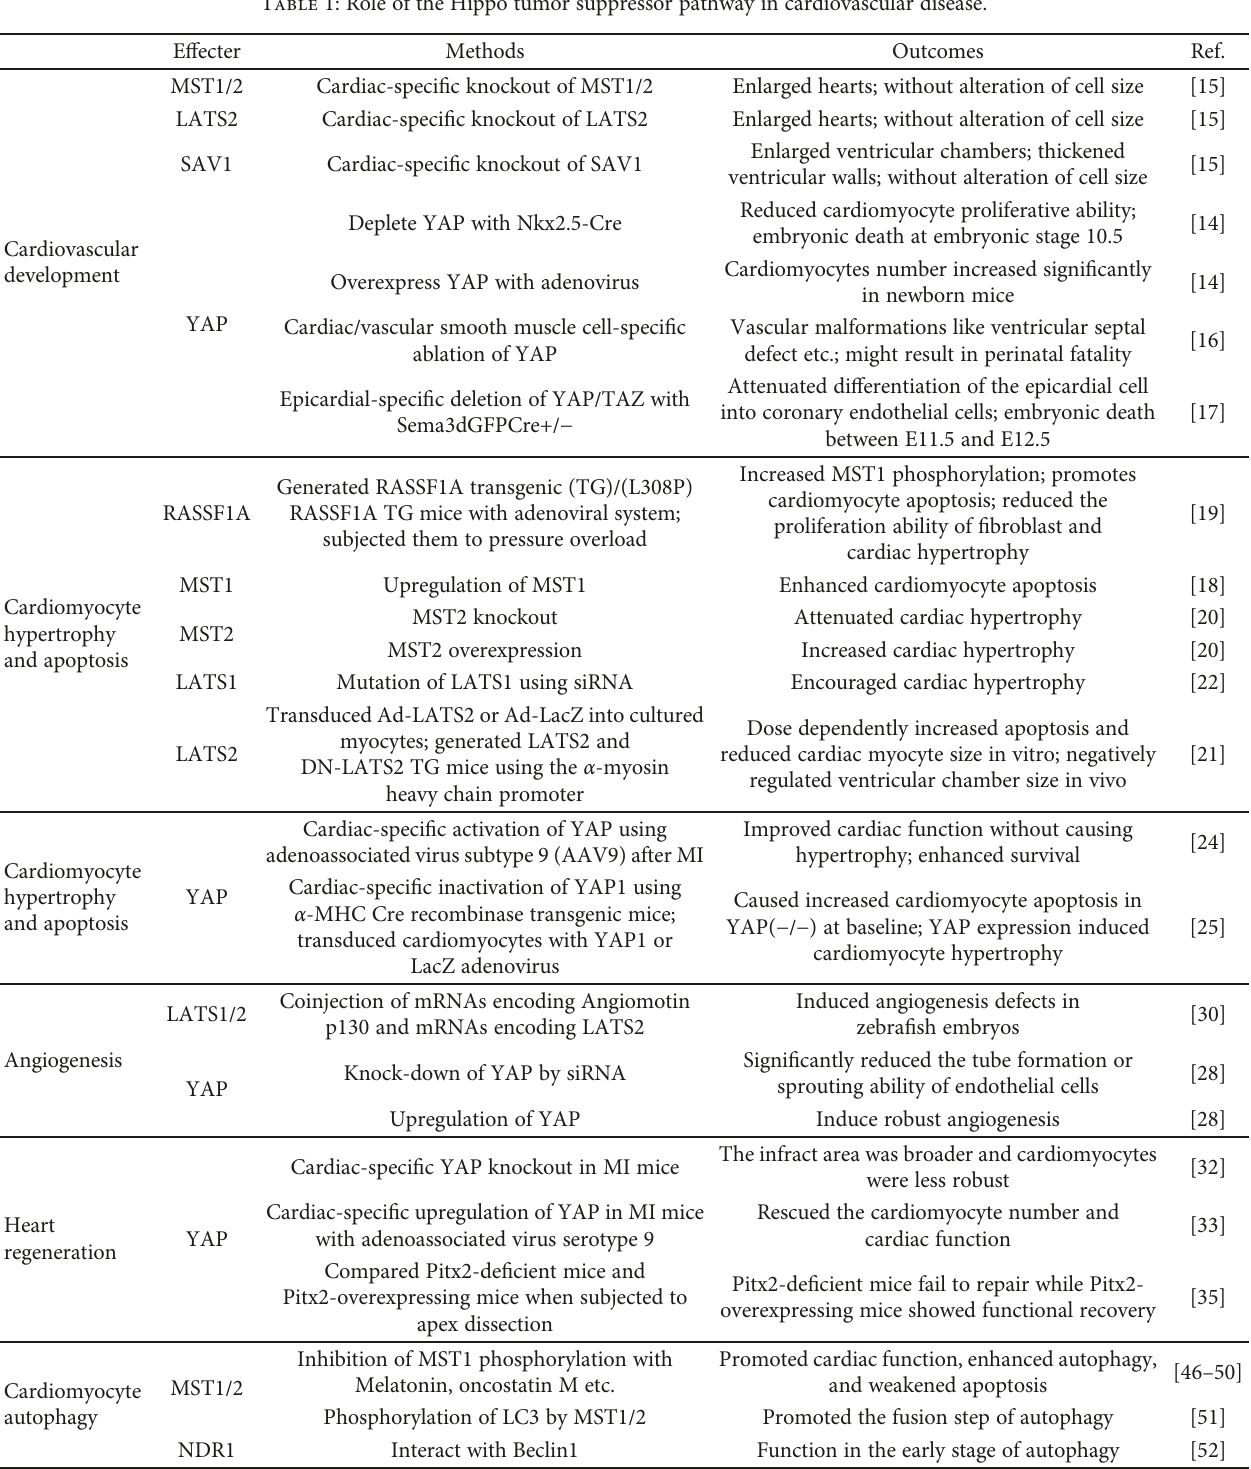
Table 1: Role of the Hippo tumor suppressor pathway in cardiovascular